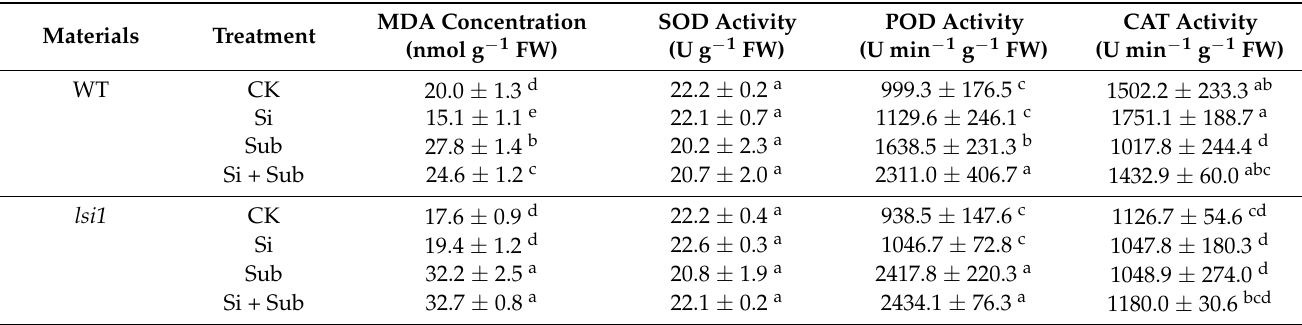
Table 4. Effects of Si application on malondialdehyde (MDA) concentration and antioxidant enzyme activity of rice under submergence